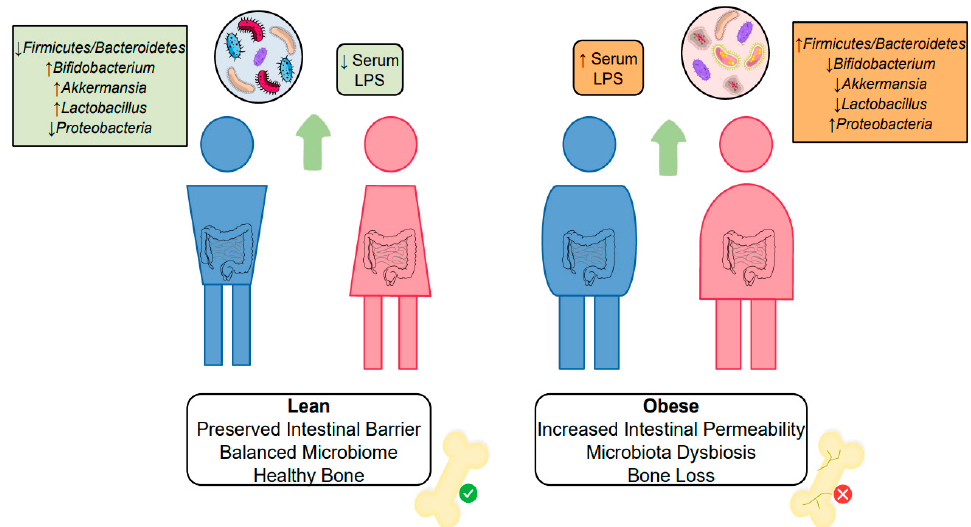
Figure 3. Impacts of gut alterations and dysbiosis on bone remodeling. Obesity promotes an increased permeability of the intestinal barrier, which leads to enhanced serum LPS concentrations. High endotoxin levels and the altered gut microbiota, with increased Firmicutes/Bacteroidetes ratio and decreased frequency of beneficial microorganisms, contribute to increased bone resorption and decreased bone formation in obesity.